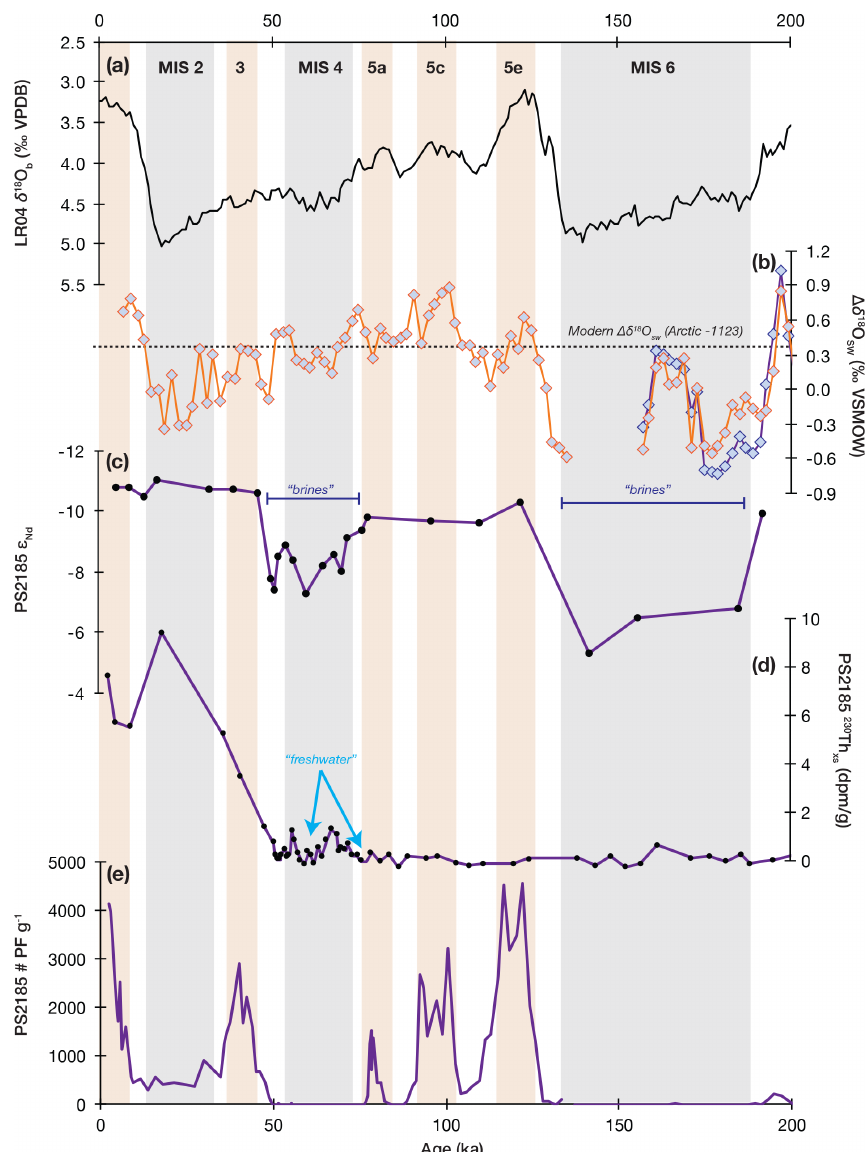
Figure 8. As in Fig. 7 but with PS2185-3/6 data plotted on the age model of Spielhagen et al. (2004). LR04 δ 18 O b stack ( a ; Lisiecki and Raymo, 2005), local intermediate-to-deep-Arctic δ 18 O sw from differencing Site 1123 (orange) and Site 607 (blue) ( b ; this study), central Arctic Site PS2185-3/6 metal oxide ε Nd ( c ; Haley et al., 2008), excess 230 Th ( d ; Geibert et al., 2021), and planktonic foraminifera abundance ( e ; Spielhagen et al., 2004). High ε Nd (plotted downward) is argued to represent increased input of Siberian weathering products to the intermediate Arctic Ocean, presumably via brine formation on the Eurasian shelves (Haley et al., 2008). Gray shading indicates glacials MIS 2, 4, and 6; orange shading indicates interglacials MIS 1, 3, and 5a, 5c, and 5e. Note the alignment of LR04 δ 18 O b stack minima (a) with PS2185-3/6 planktonic foraminifera abundance maxima (e)